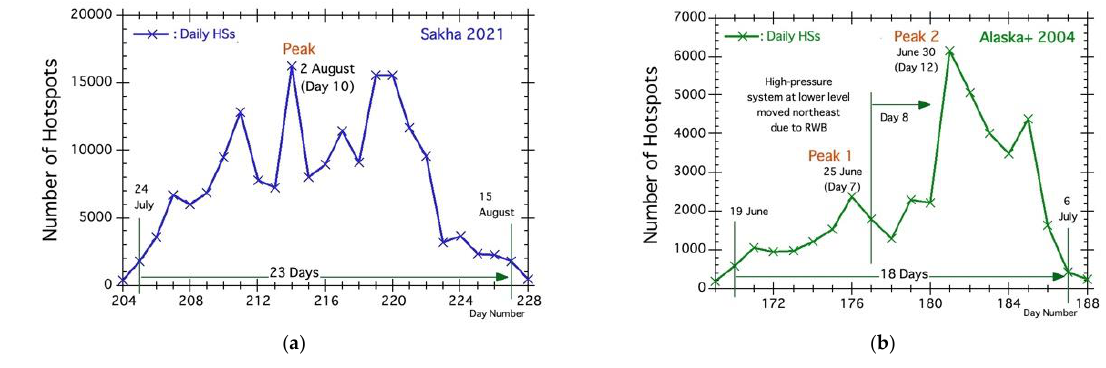
Figure 4. 2021 Fire Period. ( a ) Sakha, ( b ) Alaska.